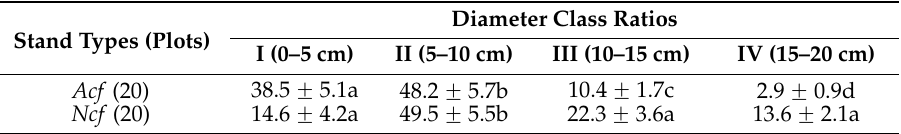
Table 4. The relative proportion of fallen trees across diameter classes.